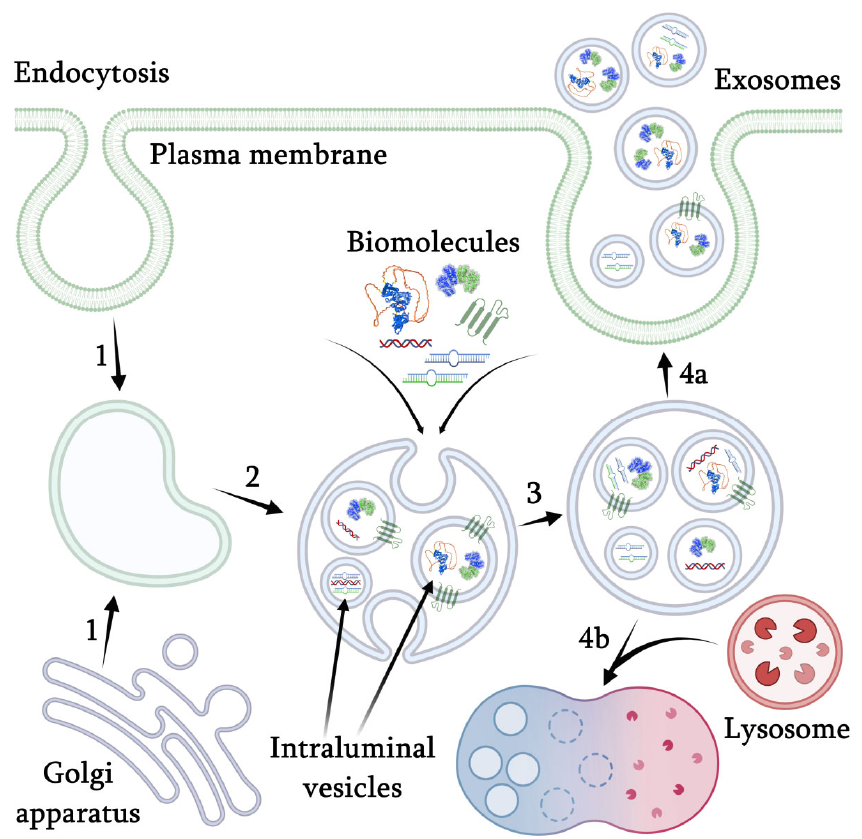
Figure 1. Mechanism of nanovesicles formation. 1—early endosome formation through the invagination of the plasma membrane cooperating with the regulatory components of the Golgi trans-network; 2—endosome maturation accompanied by invagination of the endosomal membrane with the formation of intraluminal vesicles that selectively accumulate various intracellular biomolecules by a special endosomal sorting complex: ESCRT-0, -I, -II, -III, and vacuolar protein sorting 4 (VPS4) ATPase; 3—formation of a late endosome or multivesicular body (MBT); 4a—fusion with the plasma membrane accompanied by the release of exosomes, regulated by two protein complexes from the GTPase family Rab and soluble NSF attachment receptor; 4b—fusion with lysosome and further